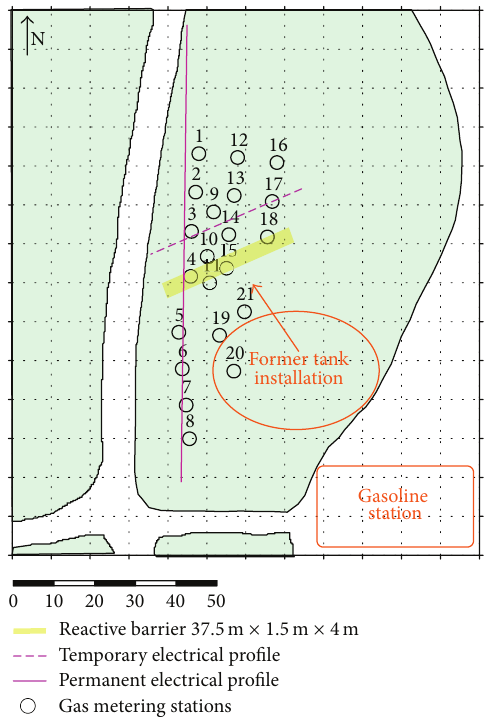
Figure 2: Map of the site showing the reactive barrier and the monitoring disposal: 2 electrical profiles and 21 gas metering